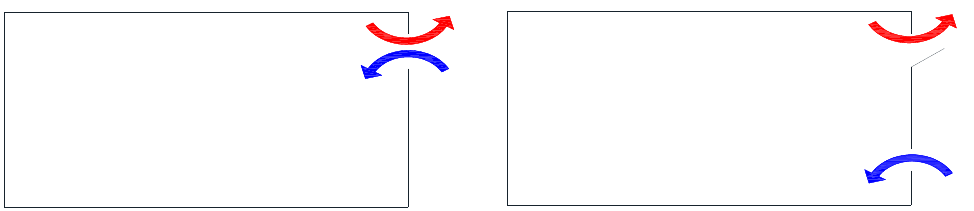
Figure 3. Single operable vent or device ( left ); bottom vent and single operable vent ( right ).